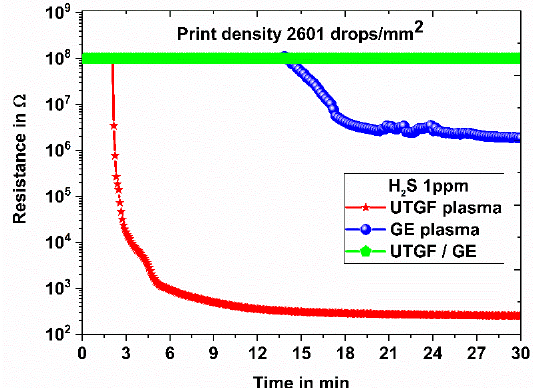
Figure 5. The effect of plasma treatment on the sensing performance of UTGFE and GE sensors at 1 ppm H 2 S.